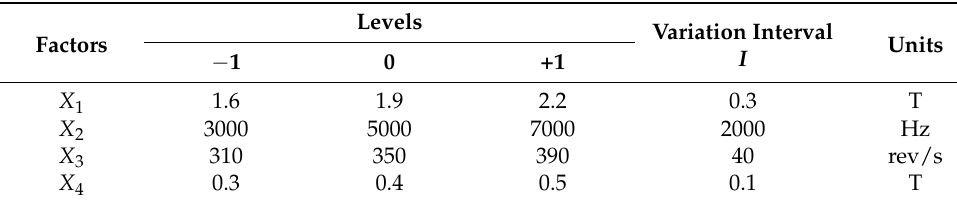
Table 1. The initial data of a full factorial experiment. Factors